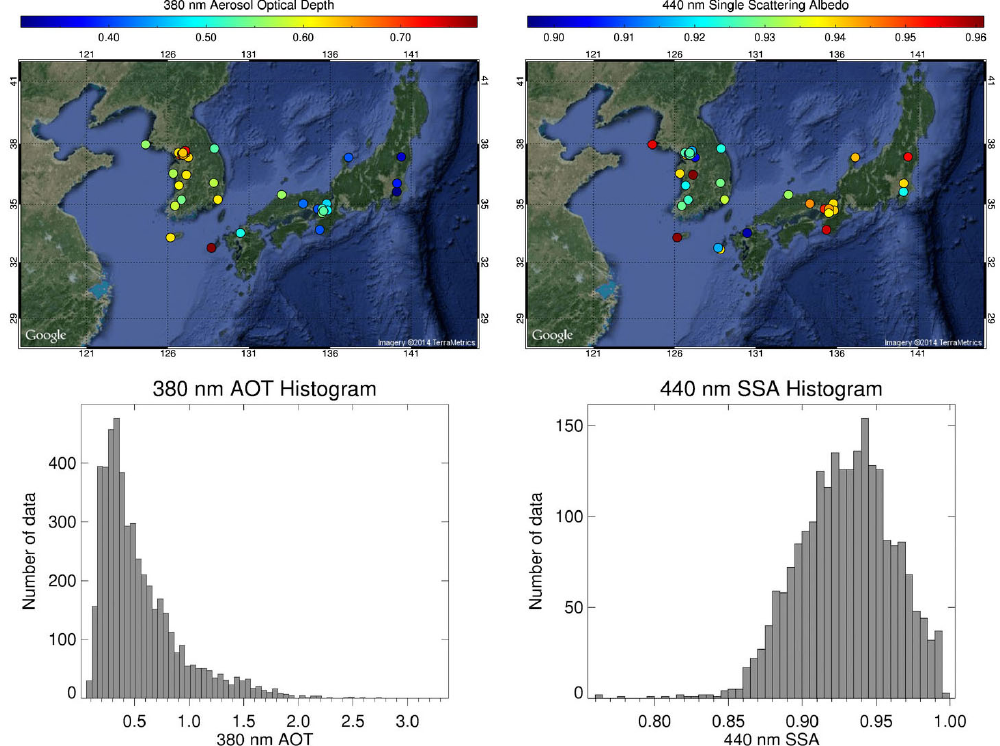
Figure 1. Mean 380nm aerosol optical thickness (AOT) and 440nm single scattering albedo and their probability density functions during the DRAGON-NE Asia 2012